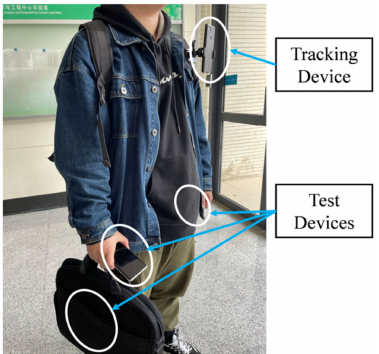
Figure 9. The scenario of data collection with different